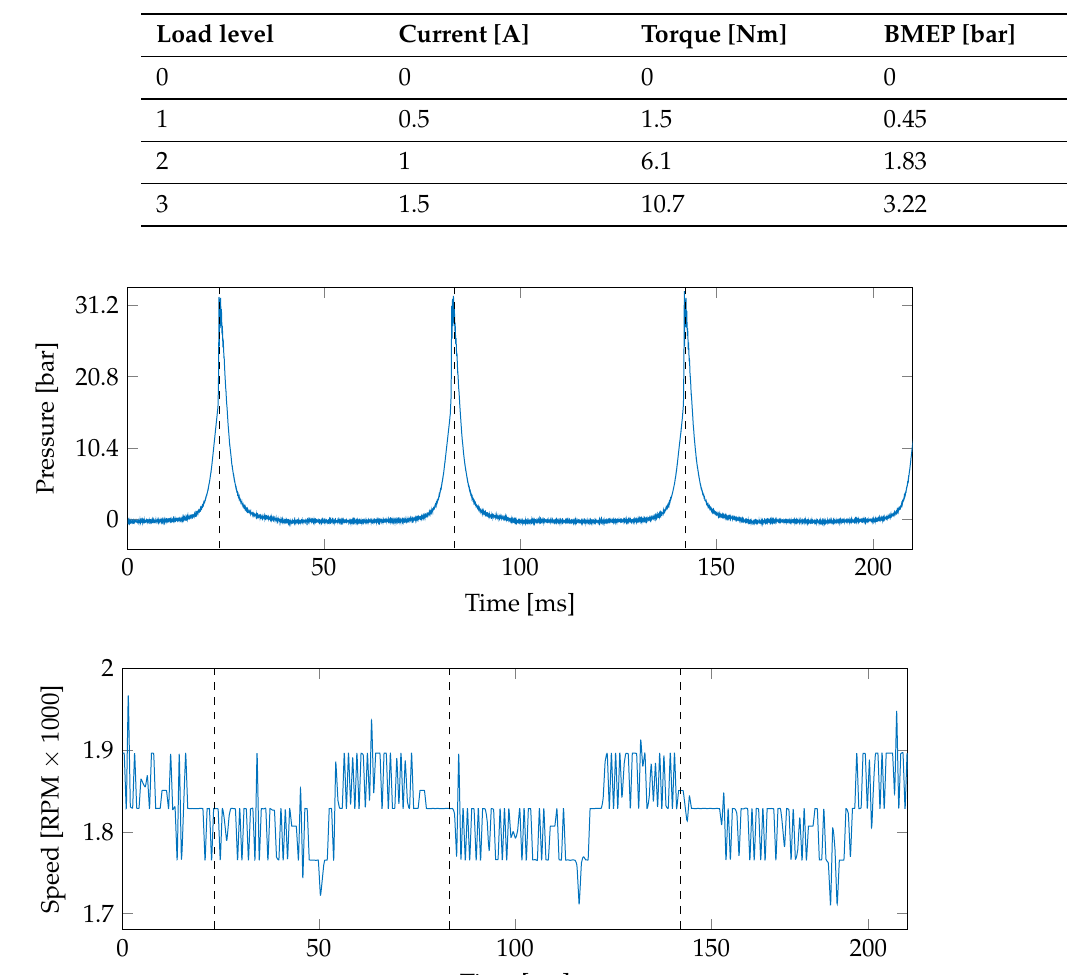
Table 4. Tested loads from an external dynamometer. The current in the dynamometer, the torque, and the equivalent load are presented.